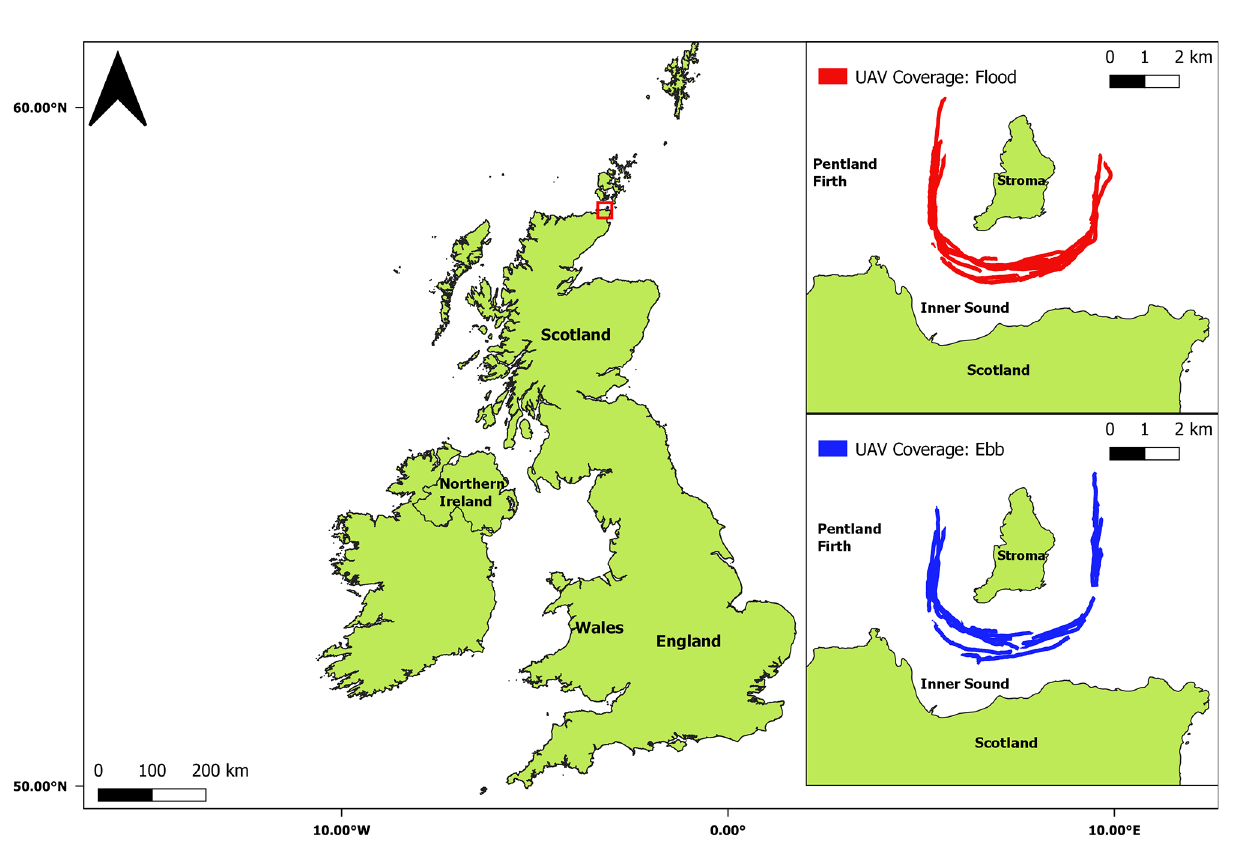
FIGURE 1 | The United Kingdom and the Inner Sound of the Pentland Firth with UAV survey coverage